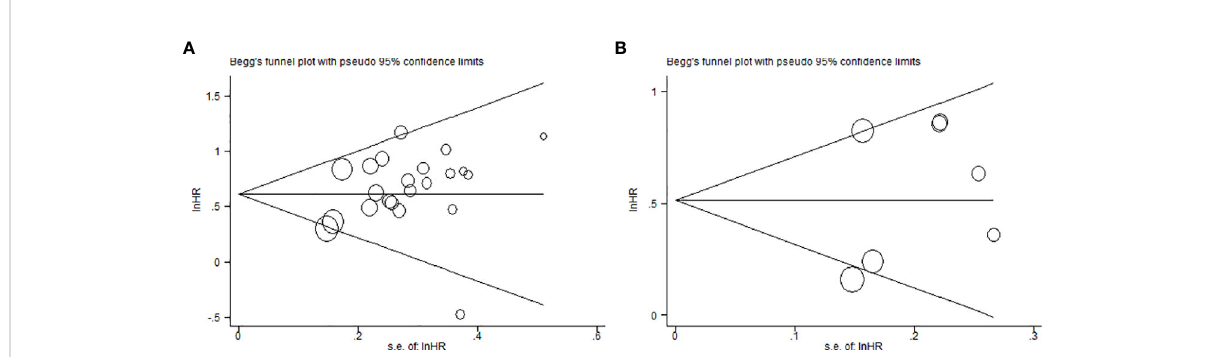
FIGURE 5 Begg ’ s funnel plots for assessment of potential publication bias in studies of MSI2 in cancer patients. (A) Funnel plot of publication bias for overall survival. (B) Funnel plot of publication bias for disease-free